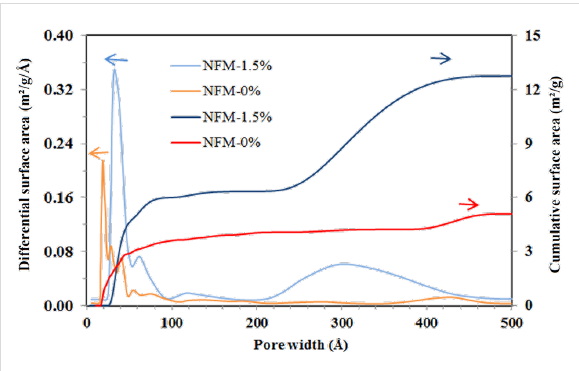
Figure 4: Differential and cumulative surface area versus pore width for NFM-0% and